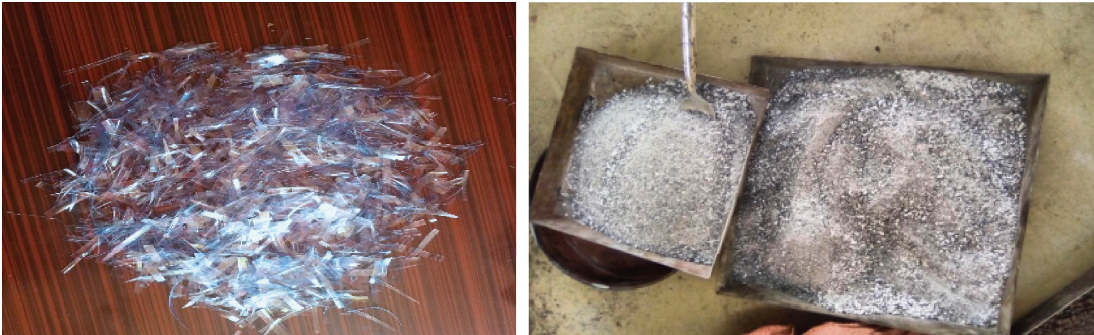
Figure 2: Waste marble and plastic strips prepared for tests.